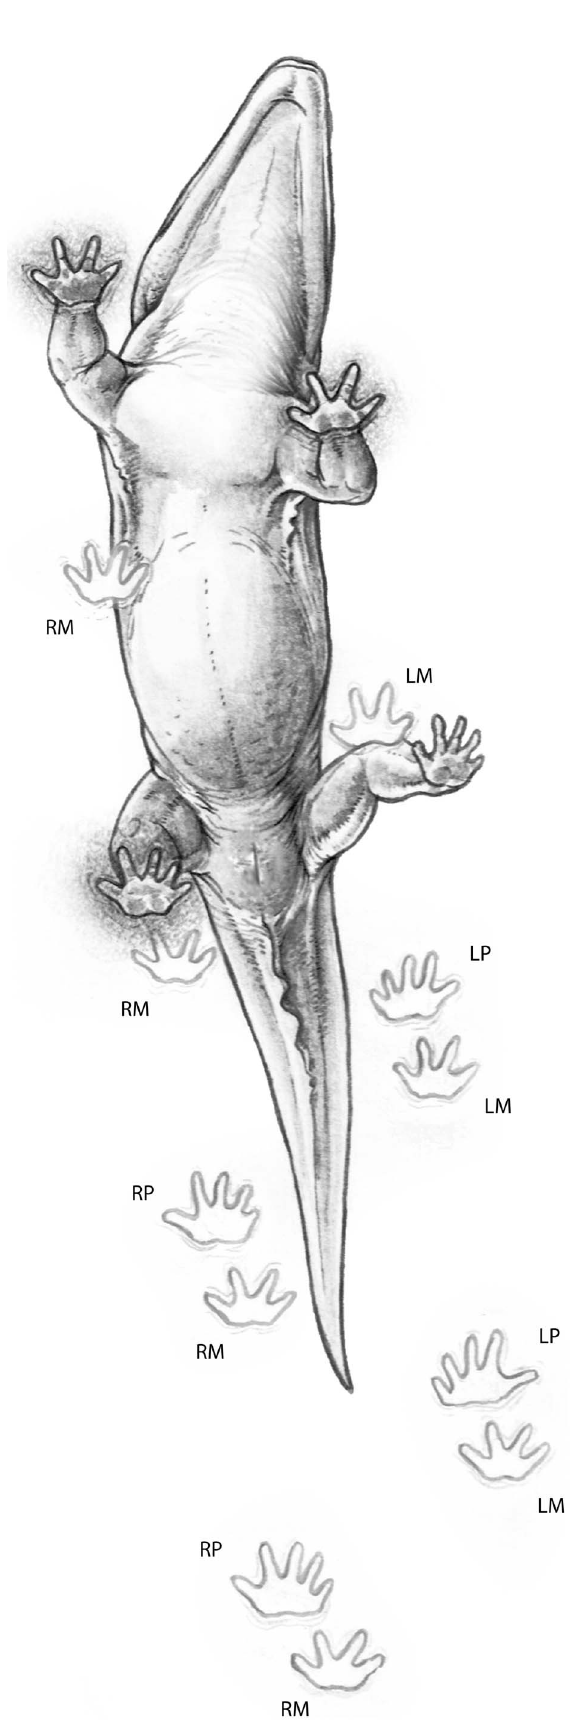
Figure 8. Secondary overstep in a ‘long-coupled’ tetrapod trackmaker. The illustration shows the underside of a stereospondyl as it progresses along a hypothetical trackway surface. The lower portion of the illustration shows the sequence of impressions made by the right and left manus ( RM , LM ) and pes ( RP , LP ) leading up to the moment just before the left pes contacts the substrate. Note that in this ‘long-coupled’ form the pes oversteps the manus of the previous stride. We infer that the Episcopopus trackmaker made tracks in this